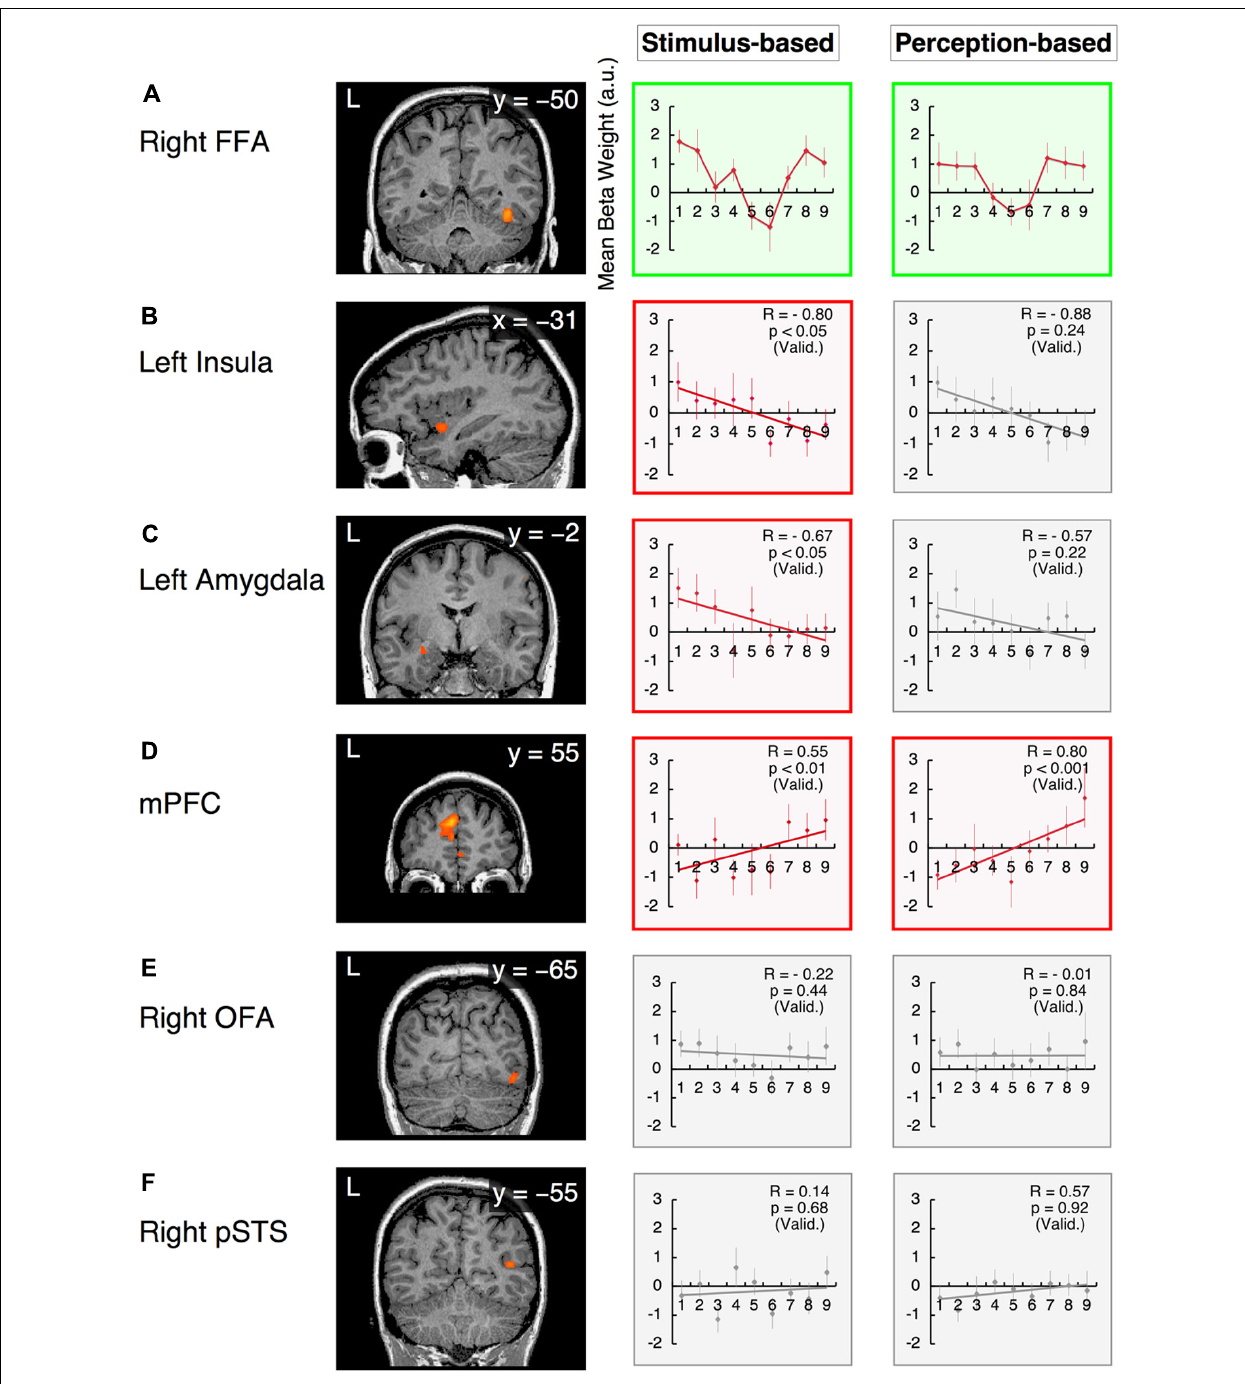
FIGURE 6 | Functional magnetic resonance imaging results in the valence dimension. The x-values represent morphed faces on the happiness − fear continuum depicted in Figure 2A , ranging from “1” = “0% happiness” to “9” = “100% happiness.”The y -values represent the BOLD signals [with arbitrary units (a.u.)] obtained from each ROI.Two graphs are provided for each ROI to indicate the results from the stimulus-based and perception-based analyses; in the latter analysis, each individual’s fMRI data are realigned in accordance with the individual’s behavioral data with respect to category boundaries ( Table 1 ).The graphs in green squares represent U -shaped or